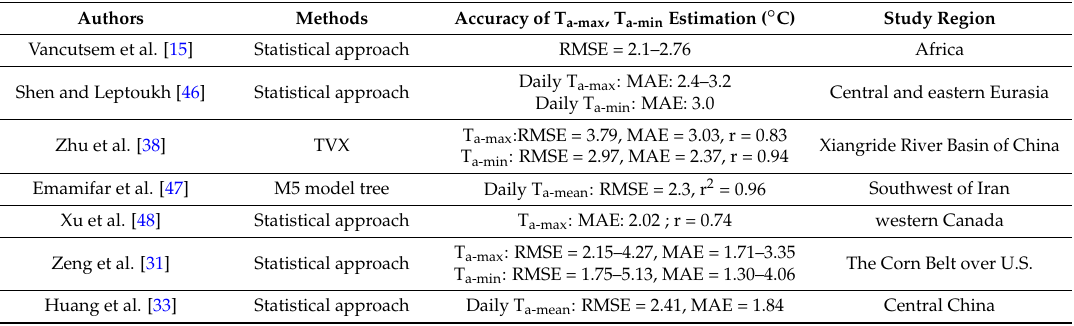
Table 1. List of daily T a temperature estimation studies using MODIS LST products in recent years. TVX, temperature-vegetation